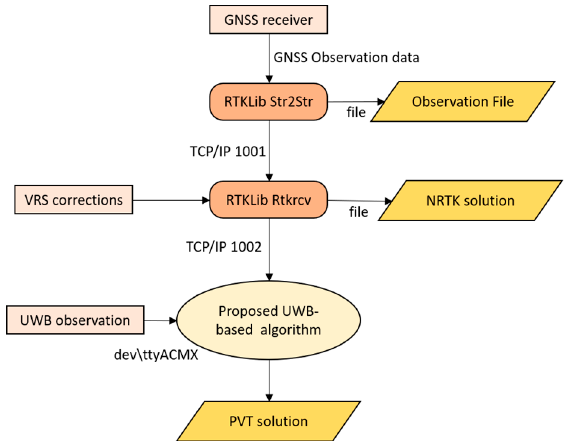
Figure 3. Communication protocols and signal flow management [14].